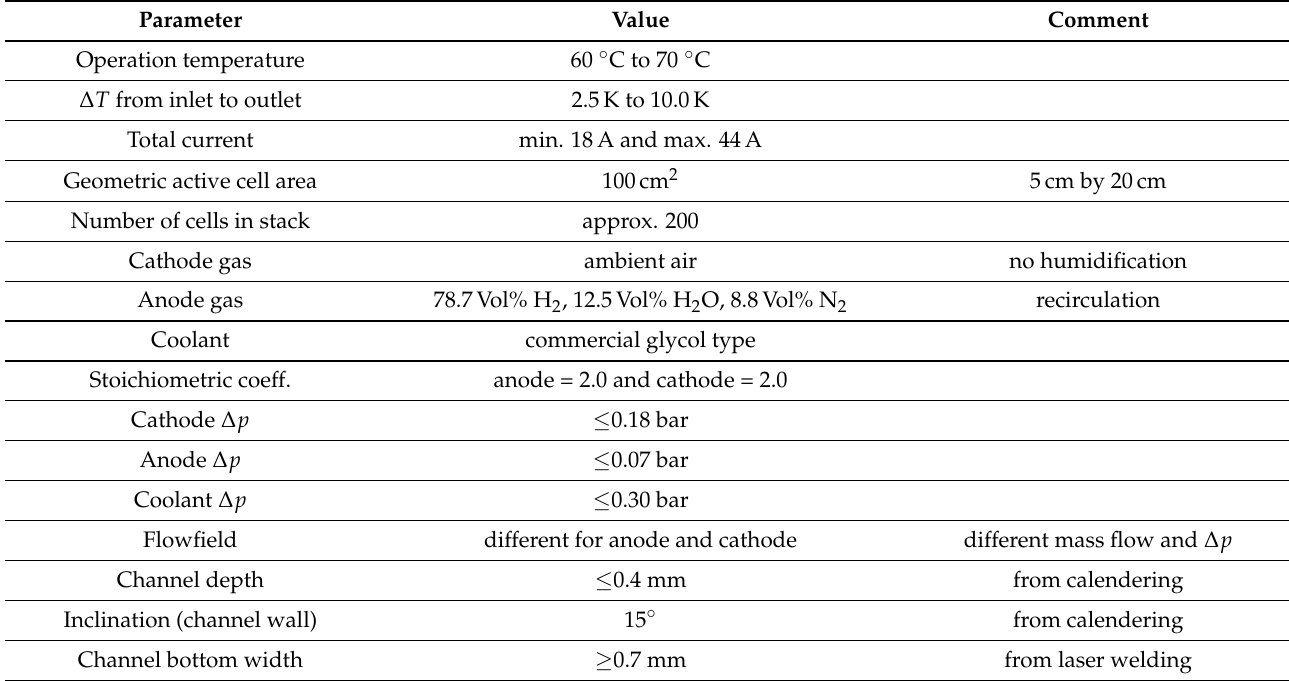
Table 1. Requirements for the range extender